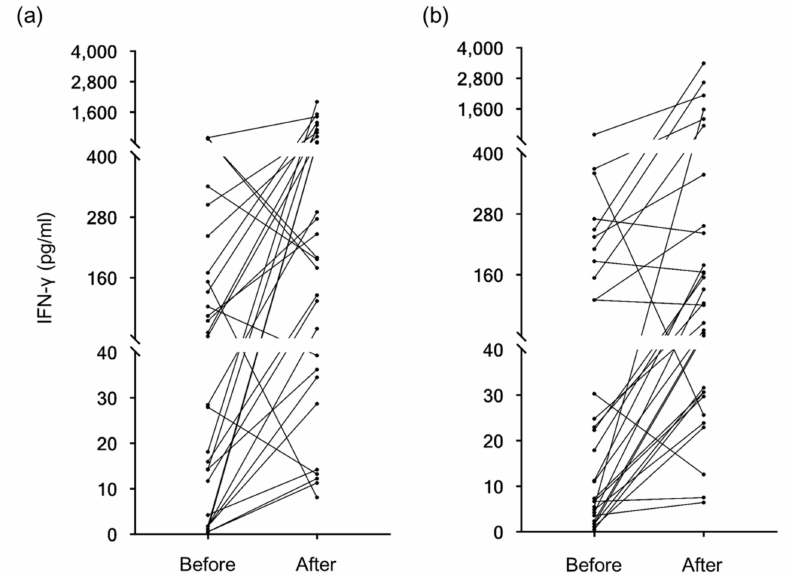
Figure 2. Results of the IFN- γ release test before and after yogurt ingestion for 8 weeks. Changes in the amount of IFN-secretion from T cells by stimulation with human cytomegalovirus (HCMV)-specific antigen are shown. ( a ) Before and after control yogurt or ( b ) 11/19-B1 yogurt